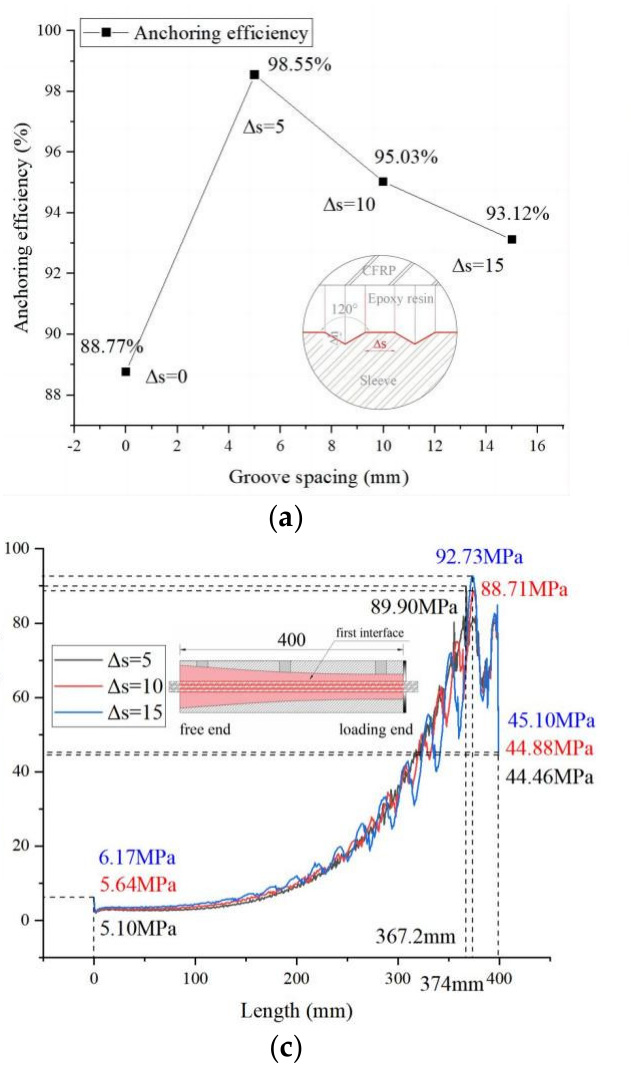
Figure 11. Effect of groove spacing on mechanical properties: ( a ) tensile test—anchoring efficiency; ( b ) FE analysis—contact compression stress of the first interface (CFRP–epoxy resin); ( c ) FE analysis—contact friction stress of the first interface (CFRP–epoxy resin); ( d ) FE analysis—contact compression stress of the second interface (epoxy resin–sleeve).